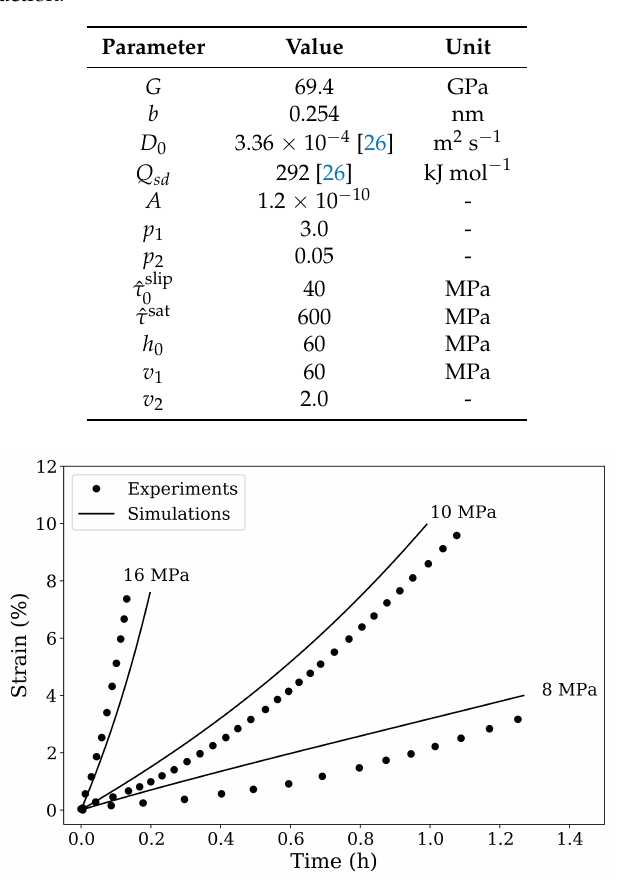
is the initial slip resistance produced 0